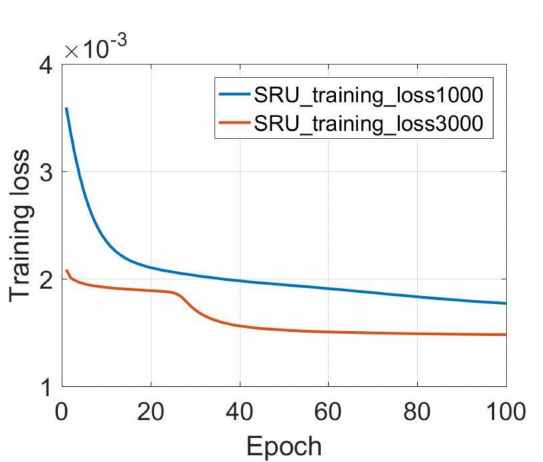
Figure 7. Y-axis gyroscope training loss comparison.